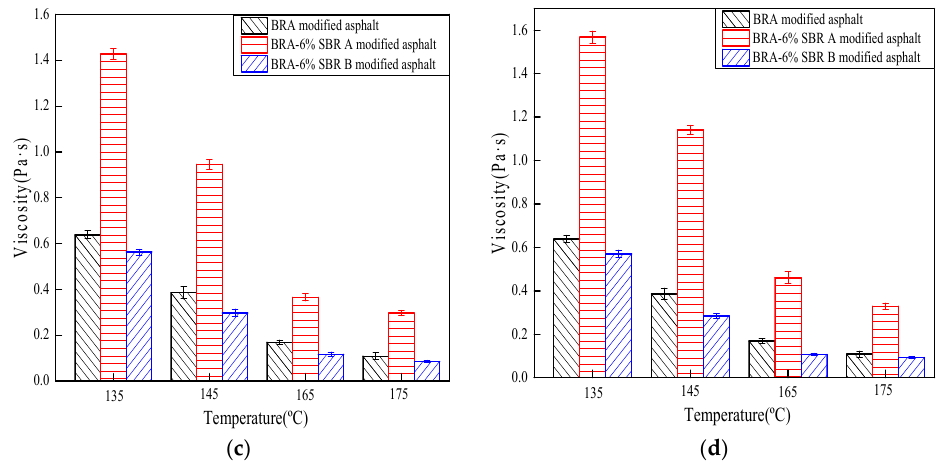
Figure 2. Viscosity of specimens. ( a ) BRA and 2%BRA-SBR modified asphalt; ( b ) BRA and 4%BRA- SBR modified asphalt; ( b ) BRA and 6%BRA-SBR modified asphalt; ( d ) BRA and 8%BRA-SBR modified asphalt.